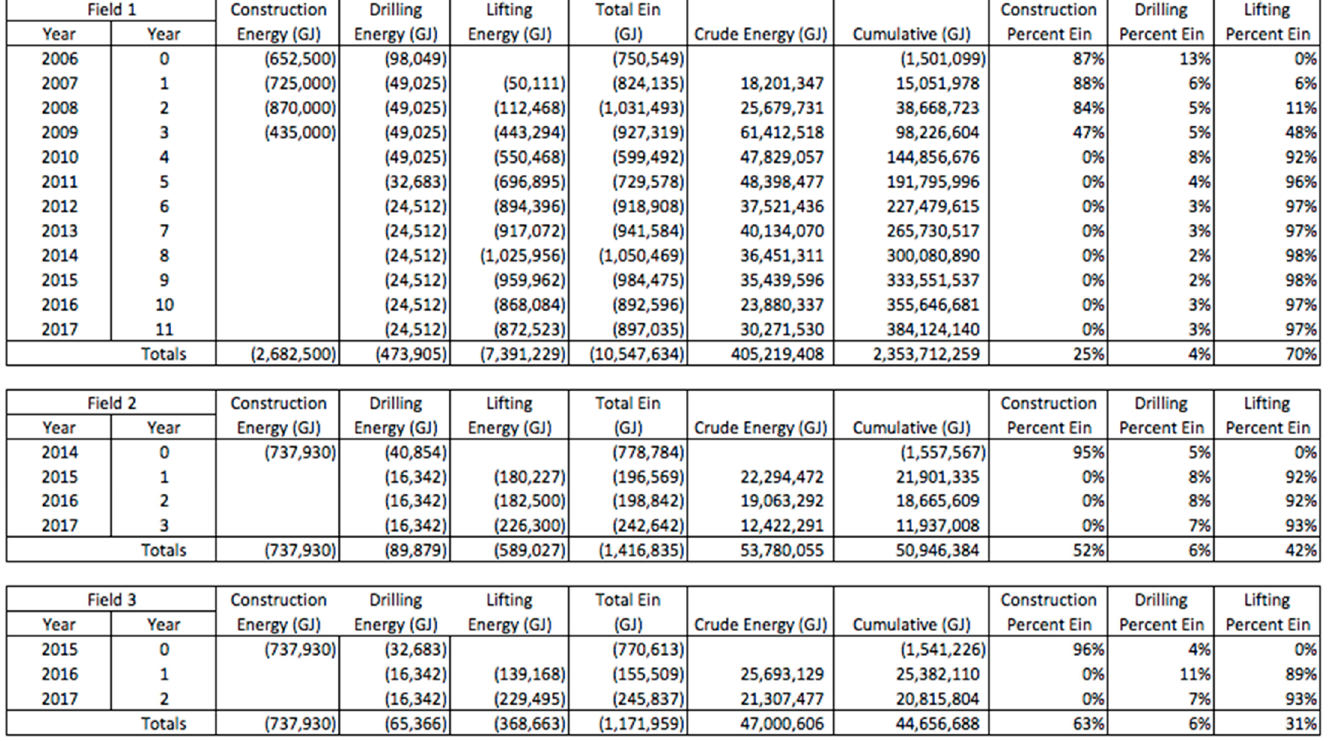
Figure A3. Energy Breakeven Calculation.